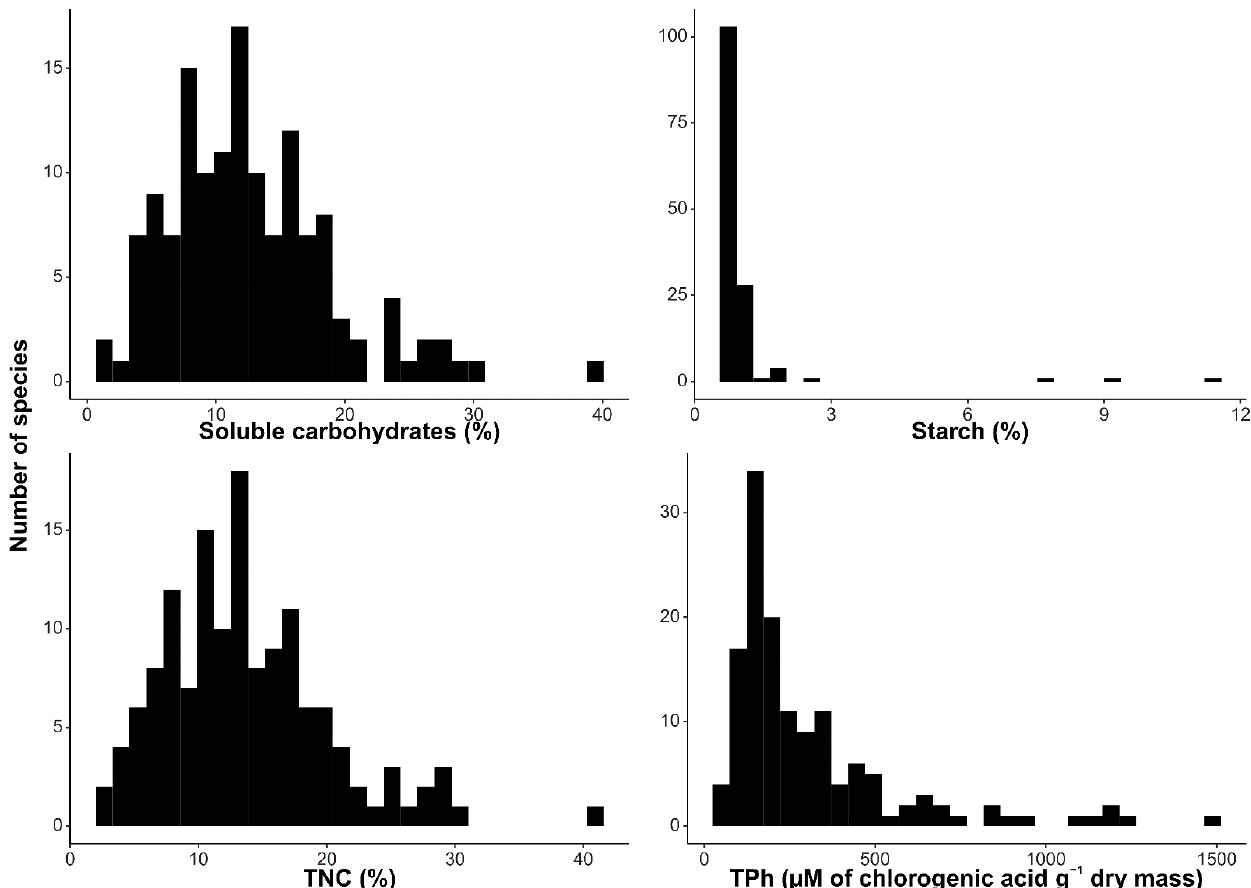
Figure 1. Distribution of the soluble carbohydrates, starch, TNC, and TPh contents for the species studied.